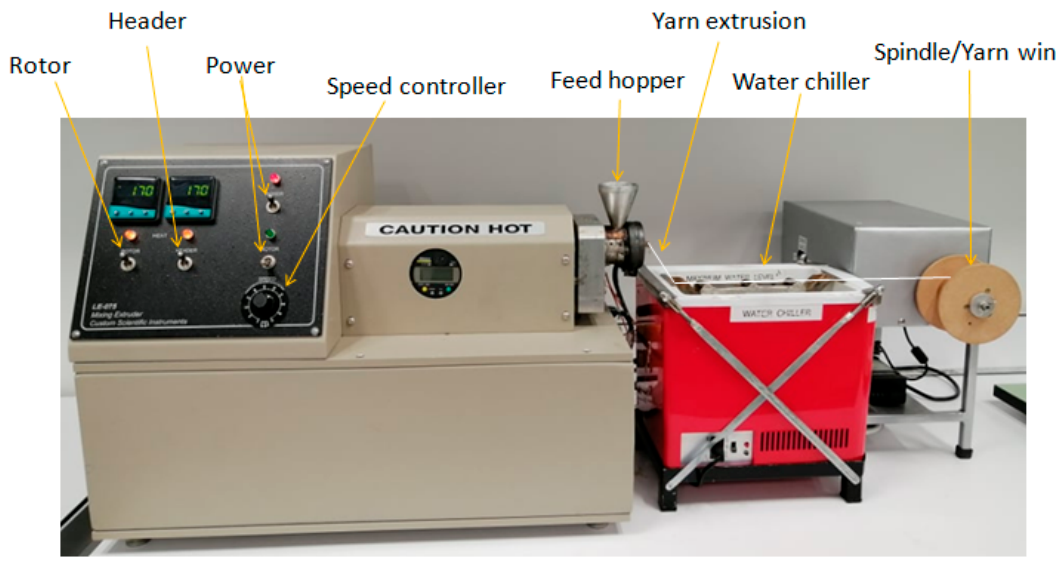
Figure 2. Schematic diagram of LE-075 Mixing Extruder.